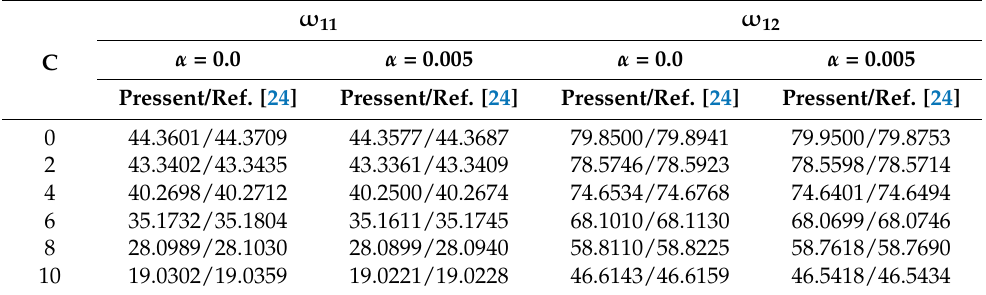
Table 1. Dimensionless natural frequencies for the axially-moving nanoplate without a